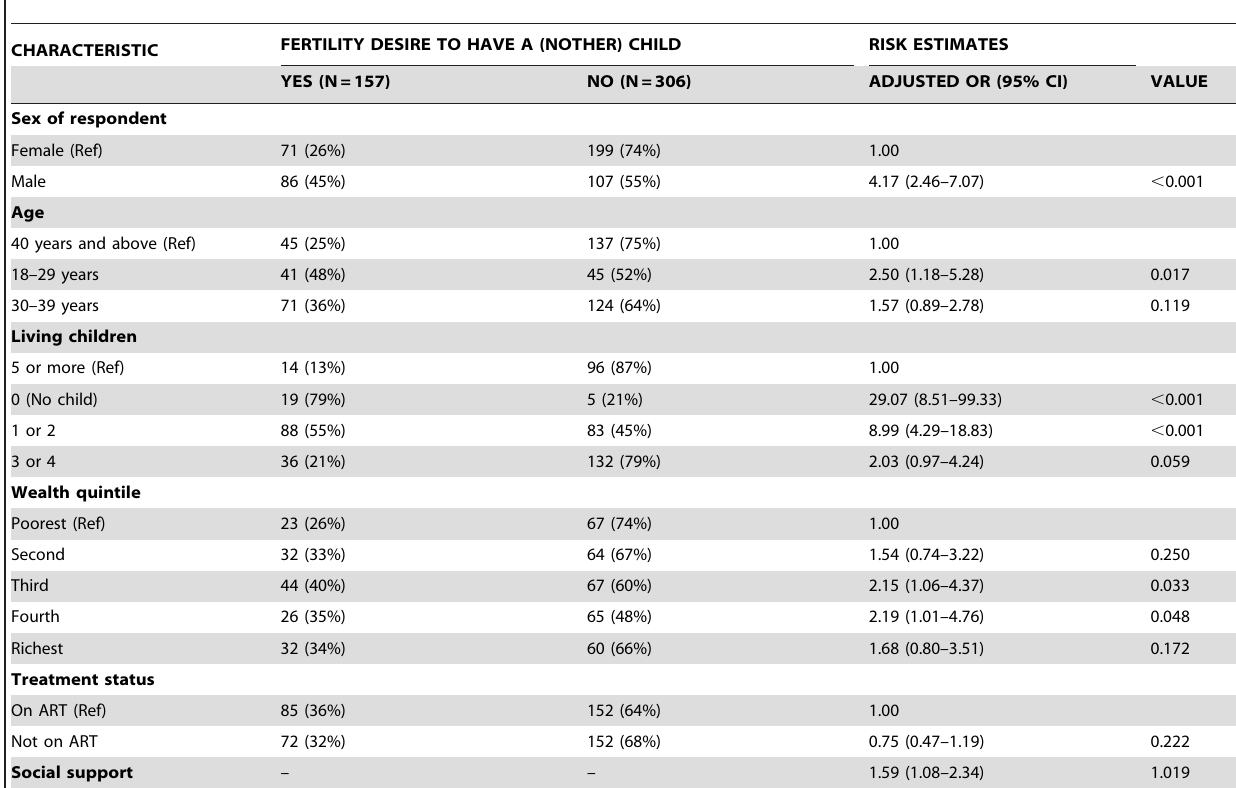
Table 2. Multivariate parsimonious model of predictors of fertility desire among men (18–59) and women of reproductive age (18–49 years) living with HIV/AIDS in Nairobi slums